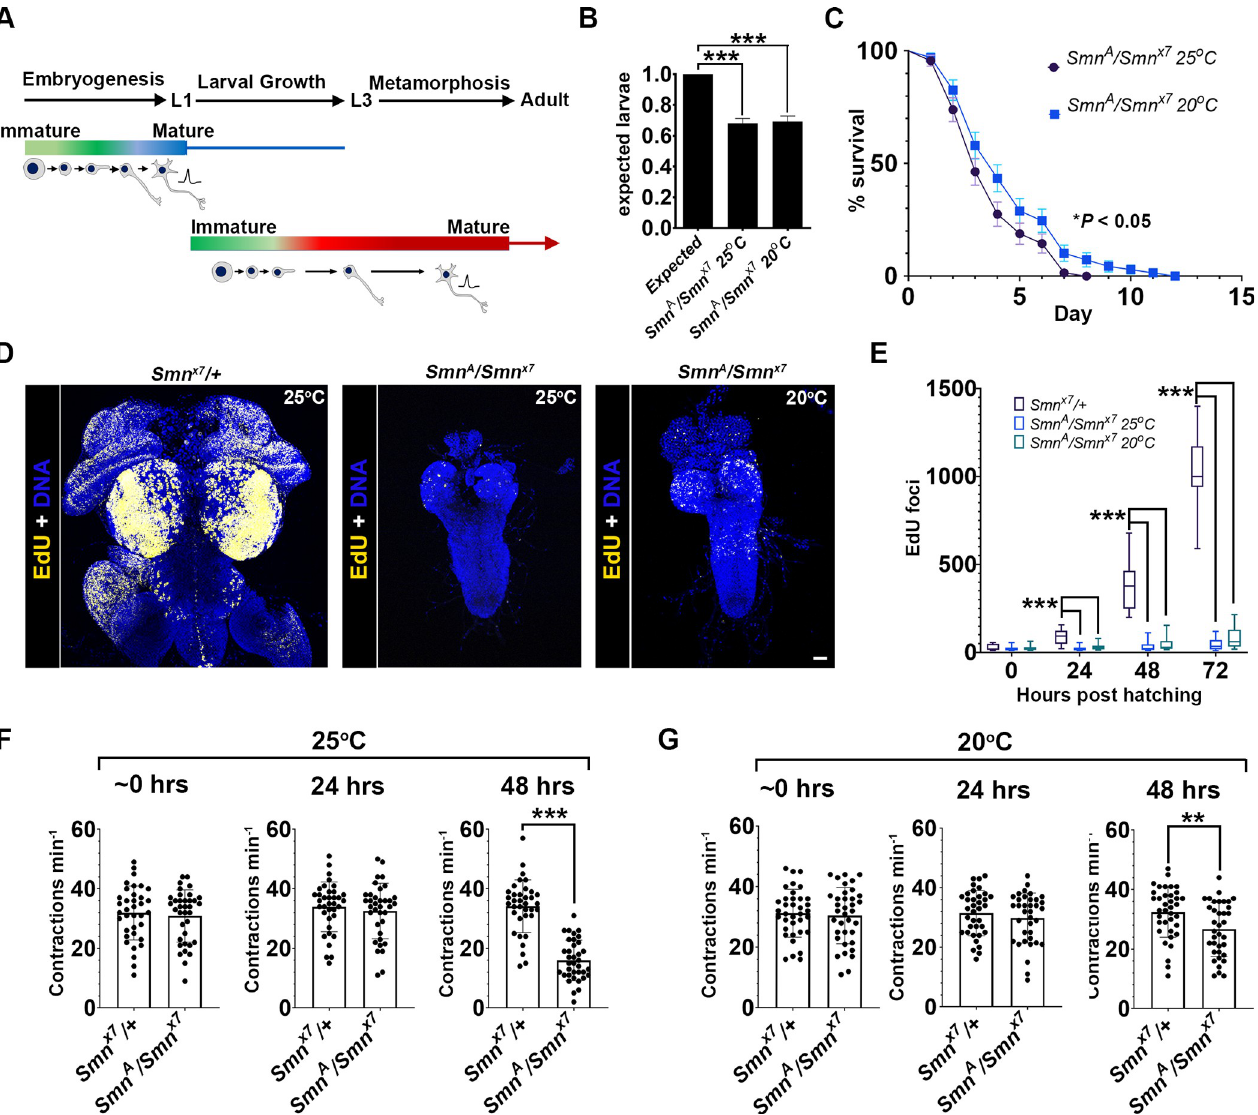
Fig 1. Neurodevelopmental defects precede gross locomotor dysfunction in Smn mutants. (A) The Drosophila developmental stages. Drosophila go through two major rounds of neurogenesis during embryogenesis, in which the larval nervous system is set up, and during the larval stage, in which the adult neurons and glia are formed (these mature during metamorphosis and early adult life); (B) Smn x7 /Smn A embryos were collected and the number of hatched larvae scored for each genotype and normalised to numbers observed from control Smn x7 /+ . Fewer Smn x7 /Smn A larvae hatched from embryos at 25˚C and 20˚C (error bars [SEM] represent three experiments, each with n > 90; ��� P < 0.001; Kruskal–Wallis test with Dunn’s multiple comparisons); (C) Smn x7 /Smn A larvae survived for a median of 3 and 4 days in a developmentally immature state when kept at 25˚C and 20˚C, respectively (error bars [SEM] represent three experiments, each with n > 60, � P < 0.05 Mantel-Cox). (D) confocal images of 5-ethynyl-2’-deoxyuridine (EdU) incorporation in Smn x7 /+ and smn x7 /smn A trans-heterozygous larvae aged 5 days; (E) counts of EdU-containing foci in the thoracic ganglion over 72 h for larvae kept at 25˚C and 20˚C. At both temperatures, Smn x7 /Smn A failed to show an increase in EdU incorporation. ( �� P < 0.01; ��� P < 0.001, n = 15 per genotype; Kruskal–Wallis test with Dunn’s multiple comparisons); (F and G) body wall contractions were scored at 0, 24 and 48 h after hatching over a 1-min period at (F) 25˚C and (G) 20˚C. Smn x7 / Smn A larvae underwent significant contraction defects at 48 h at both 25˚C ( ��� P < 0.001; Kruskal–Wallis test n = 36) and 20˚C ( �� P < 0.01; Kruskal–Wallis test n = 36). All error bars [SEM]Scale bar = 20 μ